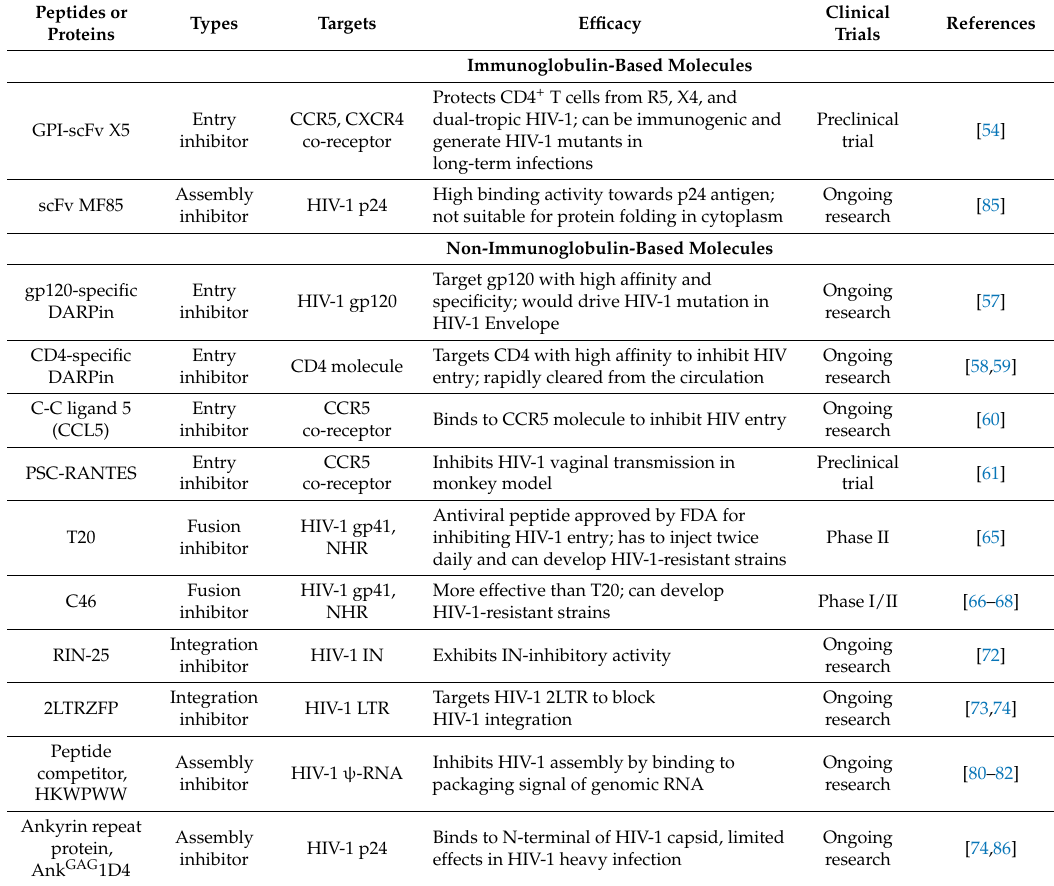
Table 2. Peptide and protein candidates for HIV-1